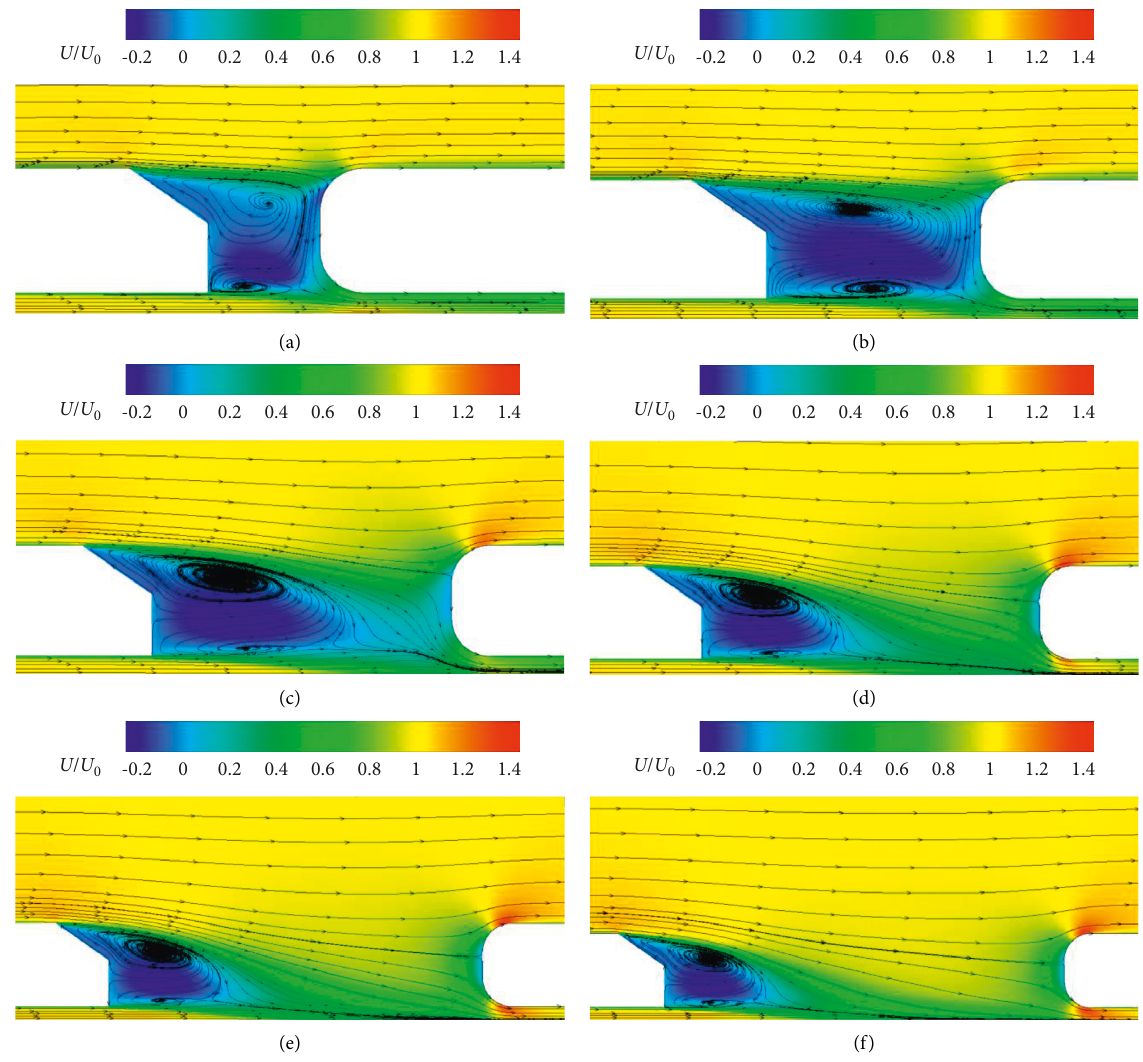
Figure 7: The x -direction velocity contour and streamline distribution between two bodies on the xz symmetry plane. (a) x/L � 0.25 (b) x/L � 0.5. (c) x/L � 0.75. (d) x/L � 1. (e) x/L � 1.25. (f) x/L �